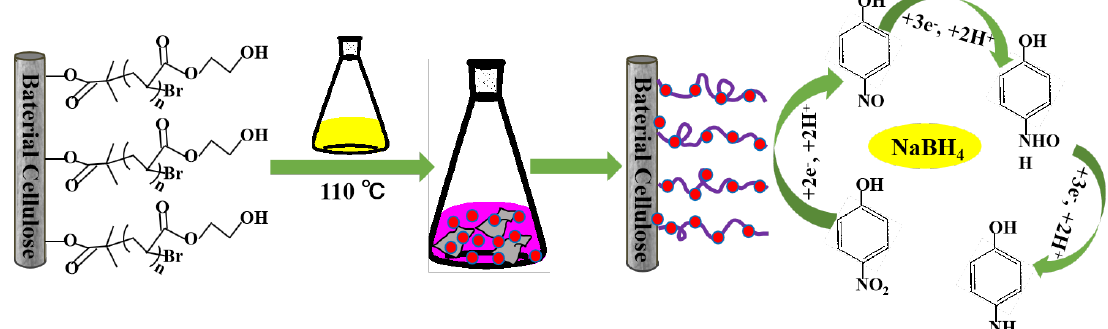
Figure 2. Illustration of the reduction mechanism of 4-nitrophenol (4-NP) by NaBH 4 occurred on the surface of gold nanoparticles (AuNPs)/bacterial cellulose 2-hydroxyethyl methacrylate (BC- poly(HEMA)).